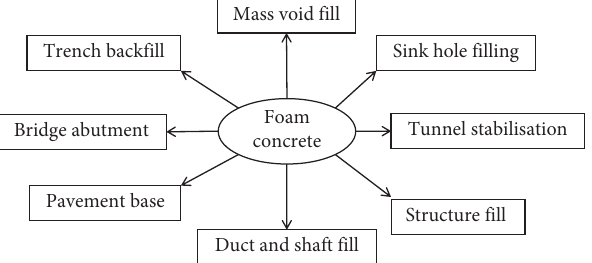
Figure 1: Different applications of